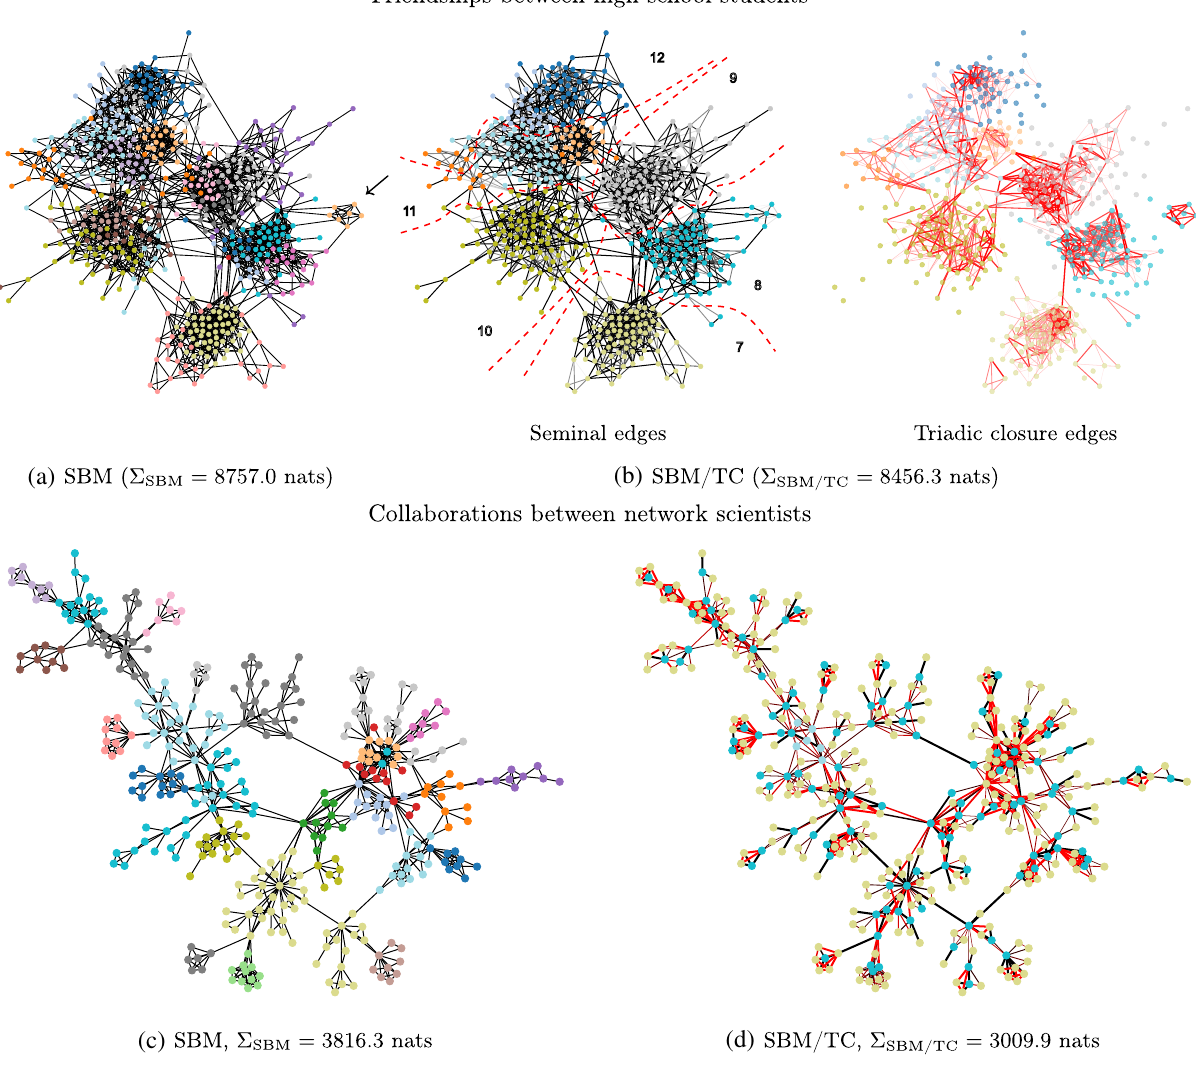
FIG. 6. Top panel: network of friendships between high school students — adolescent health (comm26) [49]. (a) Fit of the SBM, yielding B ¼ 26 communities. (b) Fit of the SBM/TC, uncovering B ¼ 9 communities, with seminal (black) and triadic closure (red) edges shown separately in the left and right panels. Bottom panel: network of collaborations between network scientists [50]. (c) Fit of the SBM, yielding B ¼ 27 communities. (d) Fit of the SBM/TC, uncovering only B ¼ 3 groups, and triadic closure edges shown in red. The thickness of the edges corresponds to the marginal probabilities π and 1 − π for the seminal and closure edges, ij ij